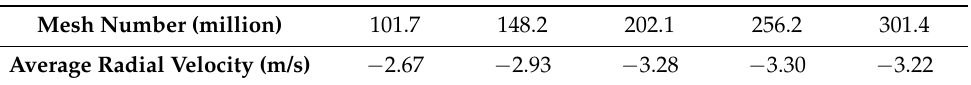
Table 1. Influence of the number of meshes on average radial velocity at the entrance of the rotor